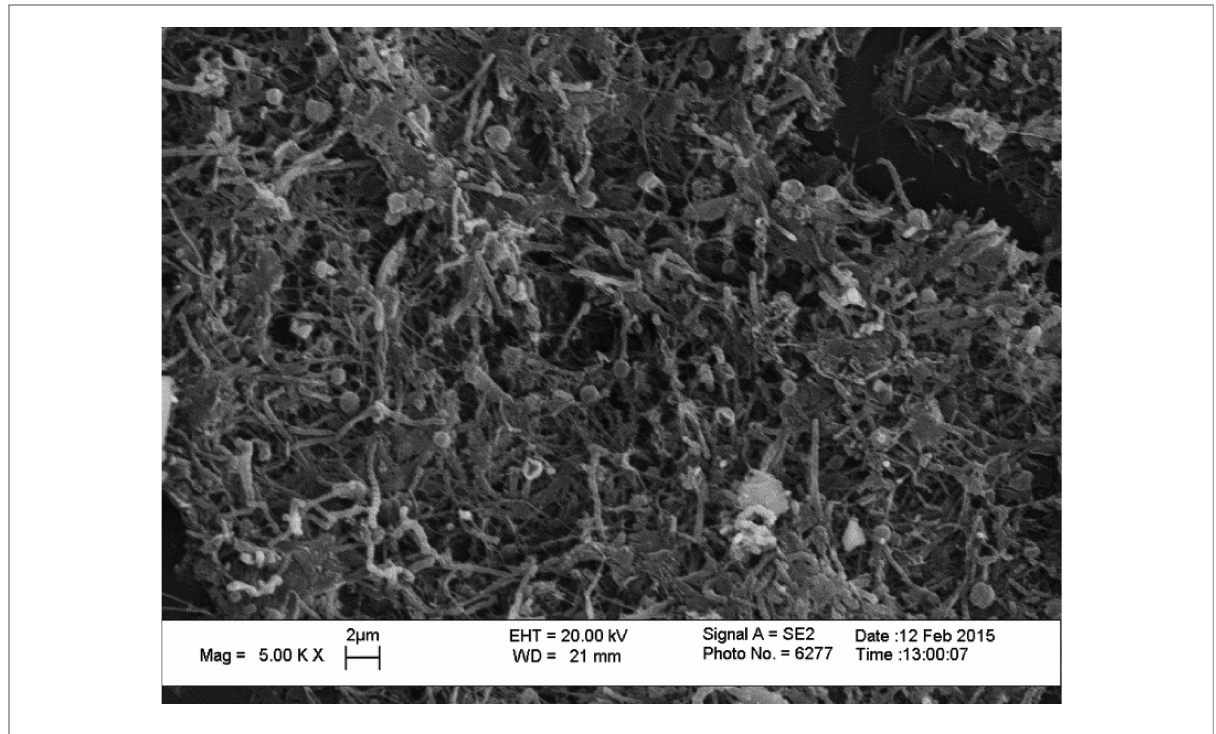
FIGURE 1 Scanning electron micrograph of the inner surface of DUWL tubing. A thick bio fi lm mass is seen on the inner surface of the